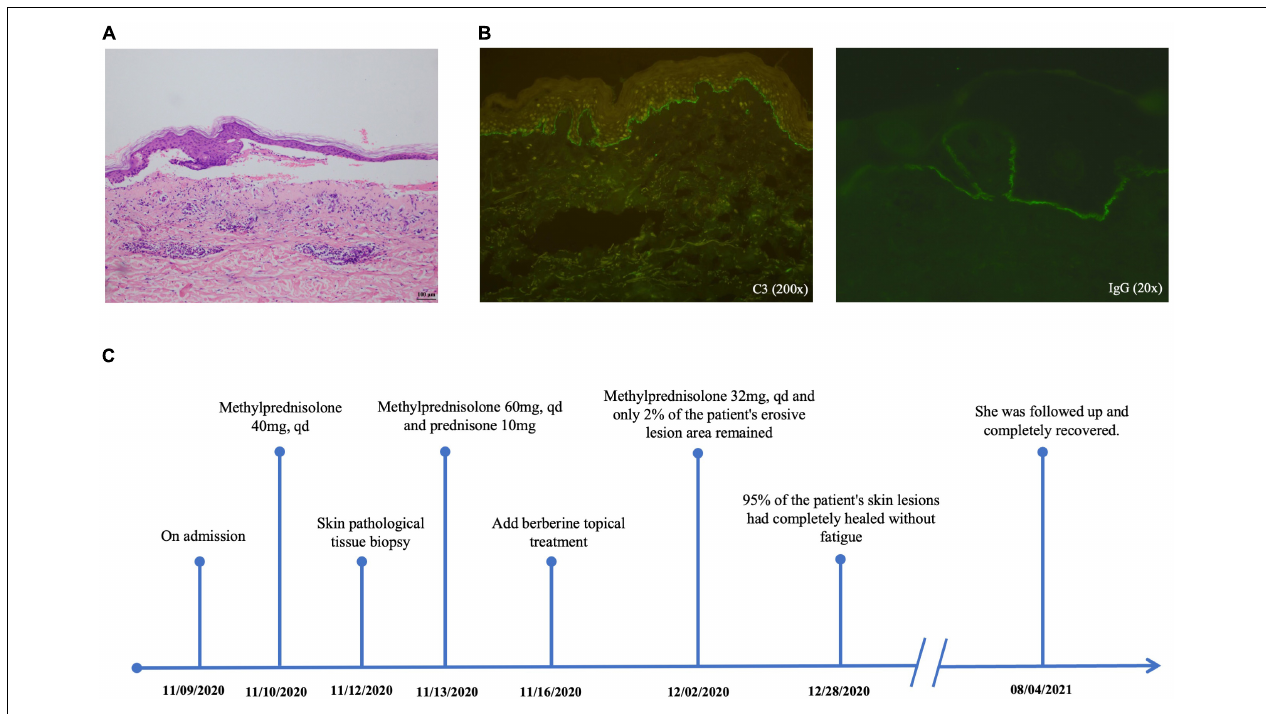
FIGURE 1 | Skin histopathology (A) shows that the epidermis is separated from the dermis with blisters in the epidermis (10 × ). Immunofluorescence staining (B) reveals linear C3 and IgG deposits along the basement membrane. Patient timeline (C) demonstrates the therapeutic schedule and disease status.